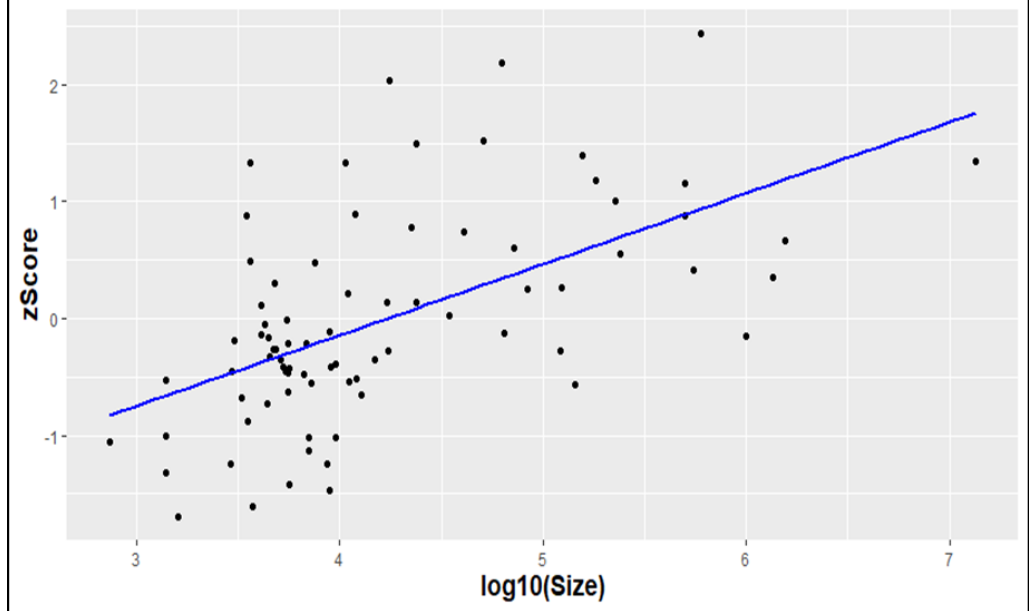
Figure 9. Log-linear regression of UGS size and mean z-score of the 34-year period.